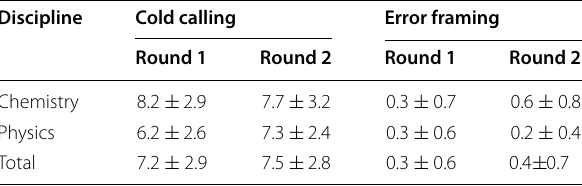
Table 1 The mean ( ± standard deviation) frequencies of cold calling and error framing implemented by GTAs in each discipline